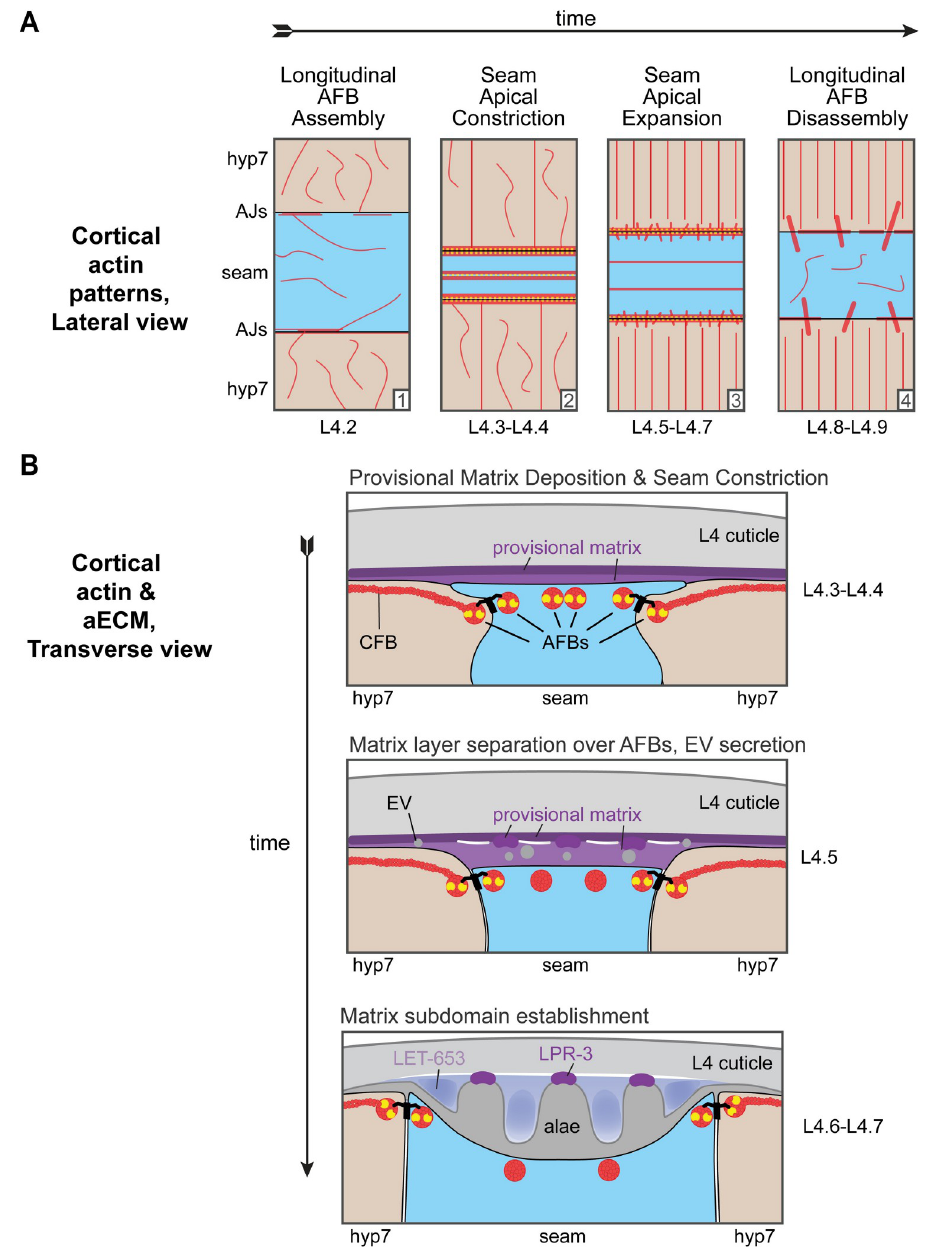
Fig 11. A cytoskeletal relay model for development of the adult alae. Seam is blue, hyp7 peach. Cortical actin networks depicted in red, NM II in yellow, and AJs between seam and hyp7 in black. (A) Graphical representation of cortical actin networks across the larval-to-adult transition. (1) Epidermis prior to longitudinal AFB assembly; (2) Seam narrowing. Longitudinal AFBs (with associated NM II) and poorly aligned hyp7 CFBs are present. The most medial seam AFBs are closely spaced and often unresolvable; (3) Seam widening. Longitudinal AFBs and well-aligned hyp7 CFBs are present. NM II is concentrated at the outer (junctional) AFBs; (4) AFB disassembly and enlargement of transverse actin spikes. (B) Graphical representation of transverse cross-sections through the seam, hyp7, and overlying matrices during early (top), mid (middle), and late (bottom) stages of alae formation. (Early) Seam narrowing and deposition of provisional matrix layers (purples). (Mid) Matrix layer separation over AFBs and beginnings of matrix patterning. Both the seam and hyp7 syncytia secrete EVs. (Late) As alae take shape, distinct provisional matrix components (purples) and cuticle components (grey) accumulate within different subdomains. LPR-3 and collagens concentrate at ridges, LET-653 (and later FBN-1) at valleys, and NOAH-1 at both ridges and